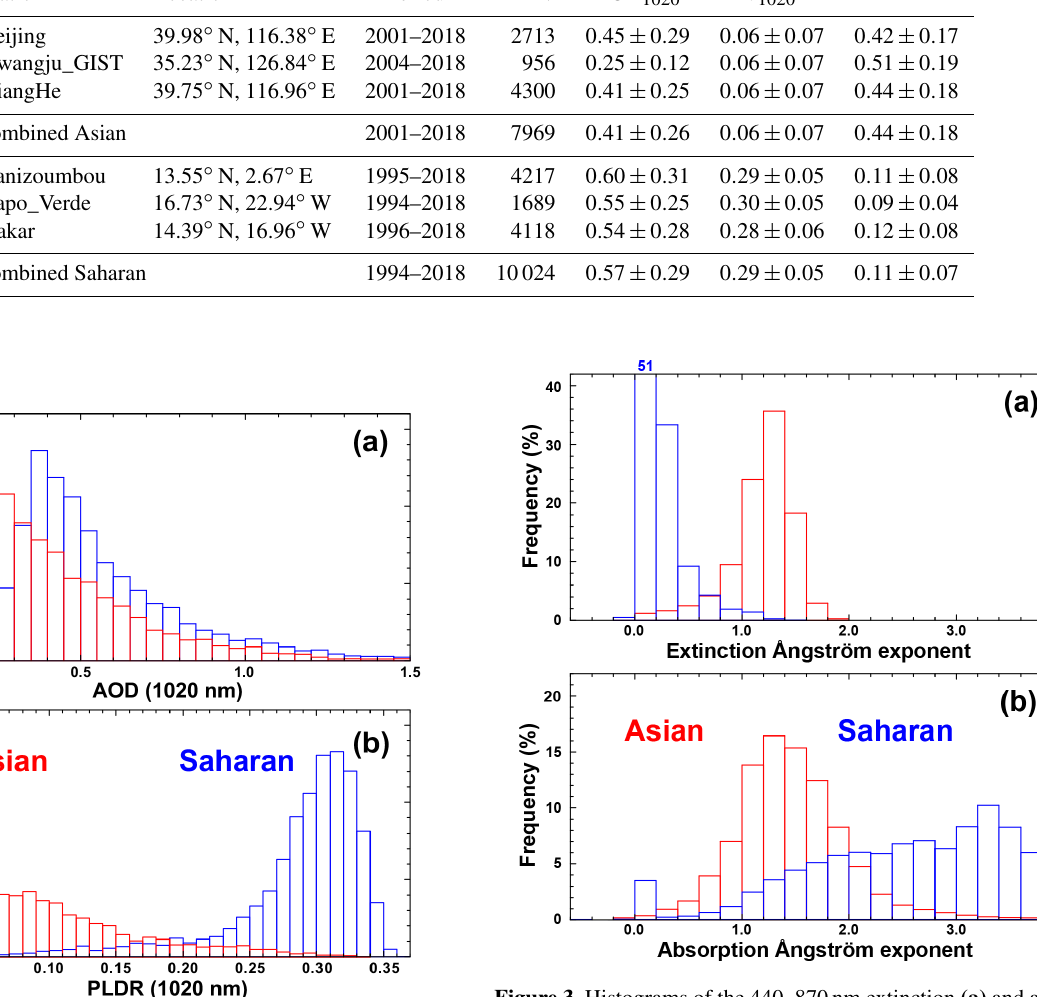
Figure 3. Histograms of the 440–870nm extinction (a) and absorp- tion (b) Ångström exponents for the considered AERONET stations affected by Saharan (blue) and Asian dust (red). The coloured num- ber provides the value for the bar that exceeds the scale. Details on the considered AERONET stations are presented in Table